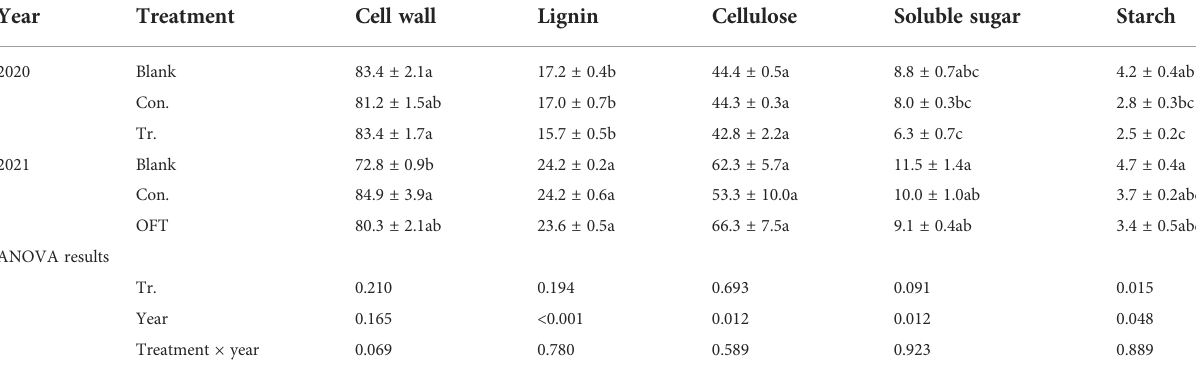
TABLE 6 Effects of soil-testing formula fertilization added organic fertilizer (STFFOF) for 11 years on carbohydrate content of rice stem